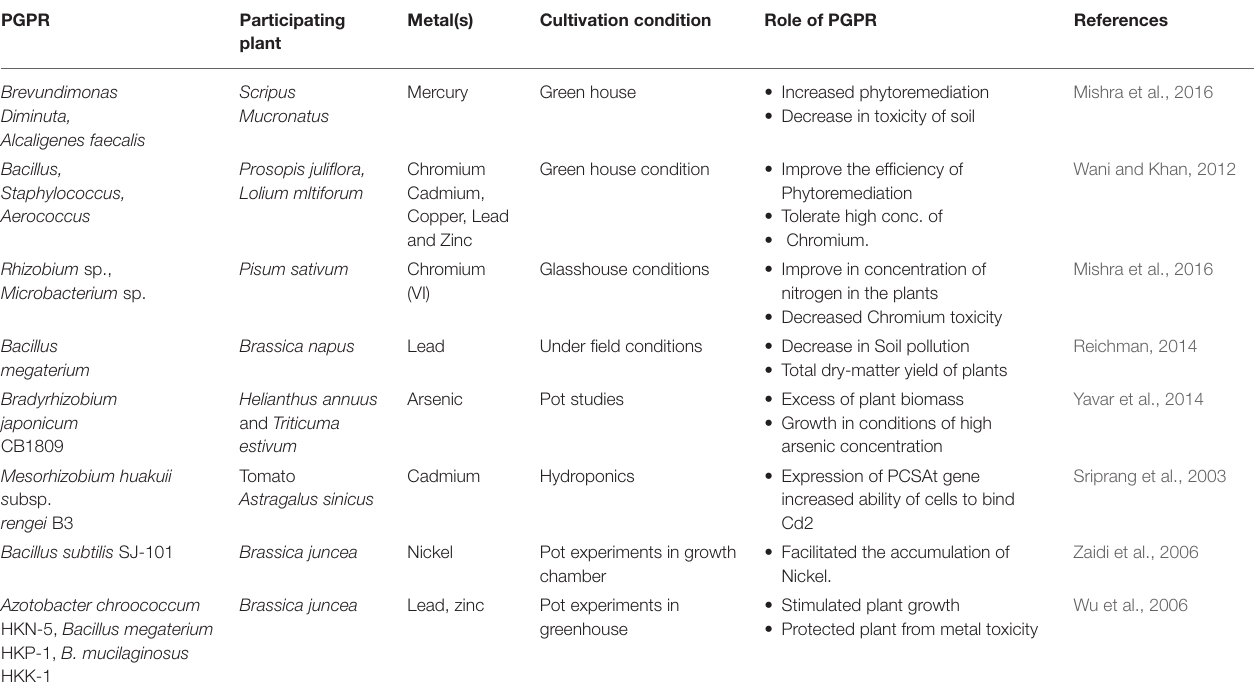
TABLE 2 | Heavy metals bioremediation by